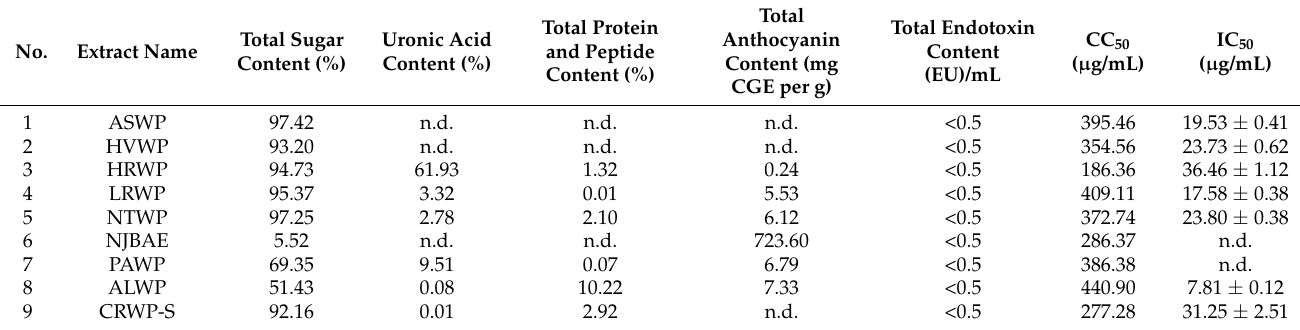
Table 2. The total carbohydrate, uronic acid, protein and peptide, anthocyanin, and endotoxin contents of the studied extracts.